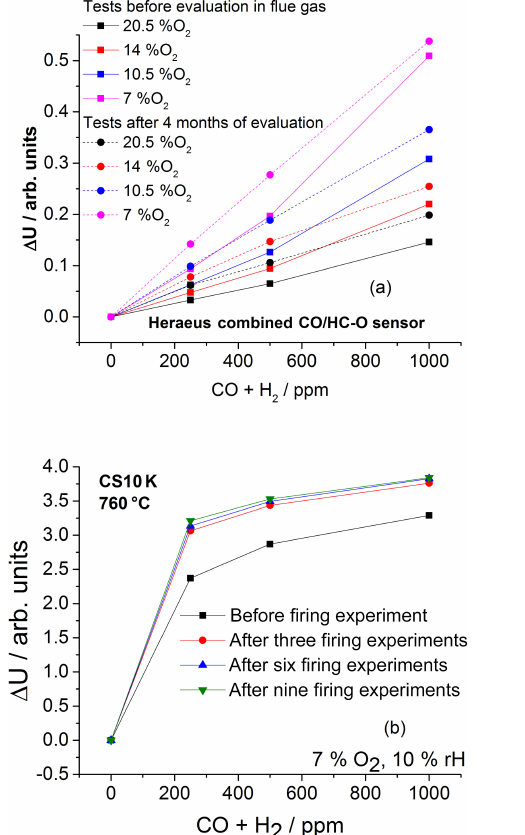
Figure 5. Evaluation of long-term stability by repeated sensor sig- nal measurements. (a) Sensor signals of HCS sensor before and af- ter 4 months of operation in the flue gas of a wood-chip central heater (field test) at different c(O 2 ), and (b) CS10K signals in model gases with 7% O 2 concentration before and after three, six and nine batch wood-log-fuelled firing